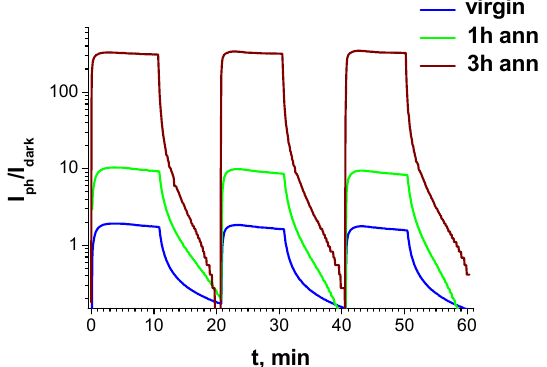
Figure 8. Transient photocurrent response of virgin nanorod arrays and those after annealing at 550